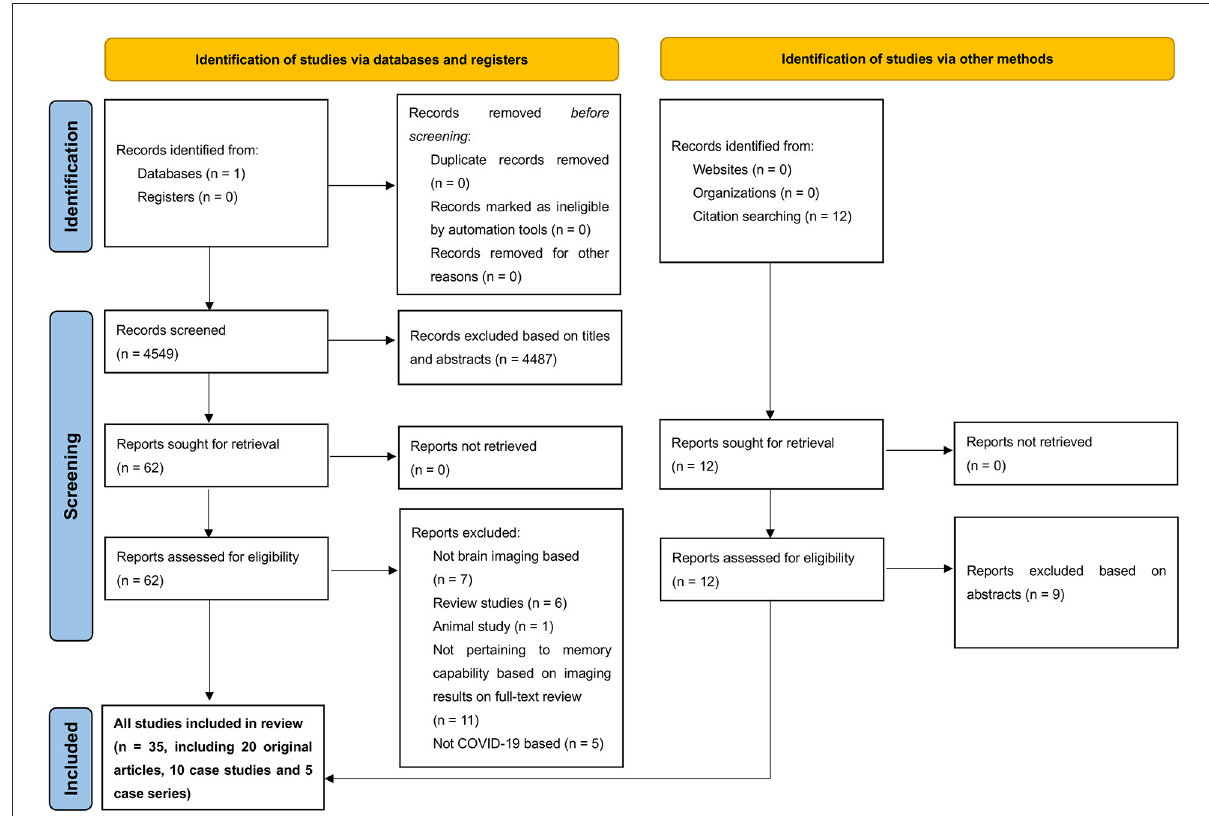
FIGURE1 Preferred Reporting Items for Systematic Reviews and Meta-Analyses (PRISMA) diagram demonstrating search